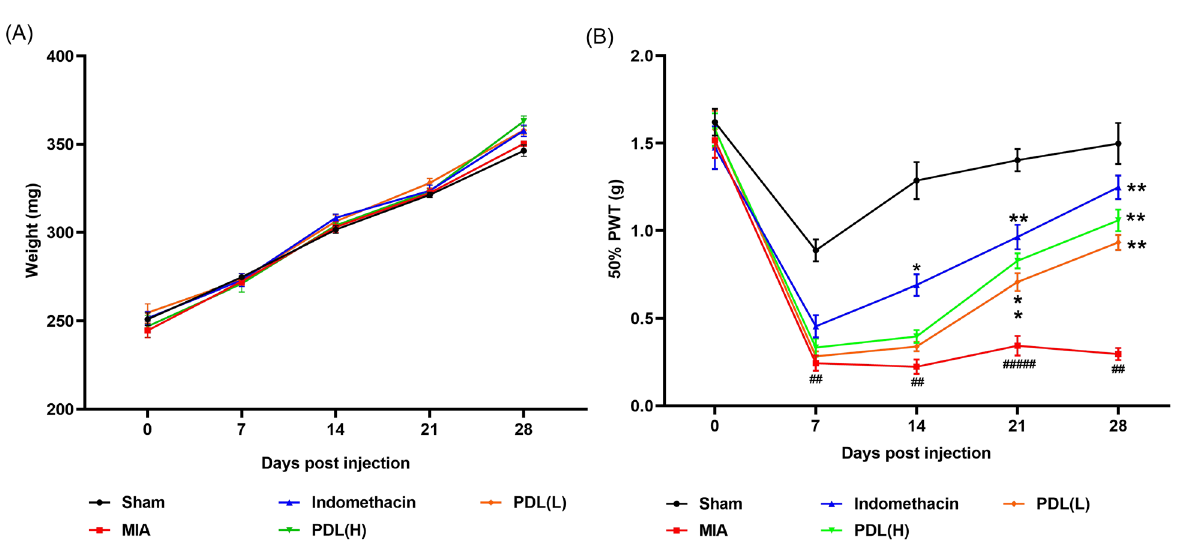
Figure 2. Effect of PDL treatment on body weight and mechanical hypersensitivity in monosodium iodoacetate (MIA)-induced OA mice. ( A ) The effect of PDL treatment on the mouse body weight. ( B ) The effect of PDL treatment on mechanical hypersensitivity in mice. All data were shown as mean ± SD (n = 10, ##p < 0.01, #####p < 0.0001 compared to the Sham group. *p < 0.05, **p < 0.01 compared to the MIA